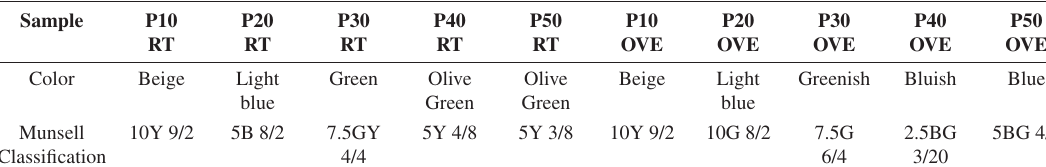
Table 2. Color and shade of the zeolitics pigments synthetized. The products with 10% of additives exhibited the same color of the reactional mixture.